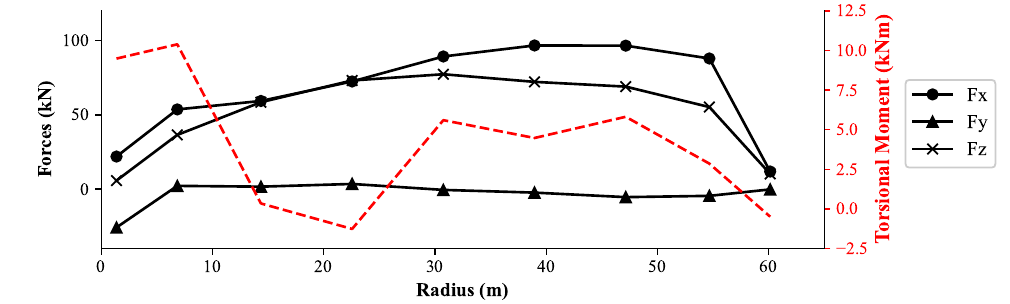
Figure 8. Concentrated loads calculated using FASTv8 on the critical